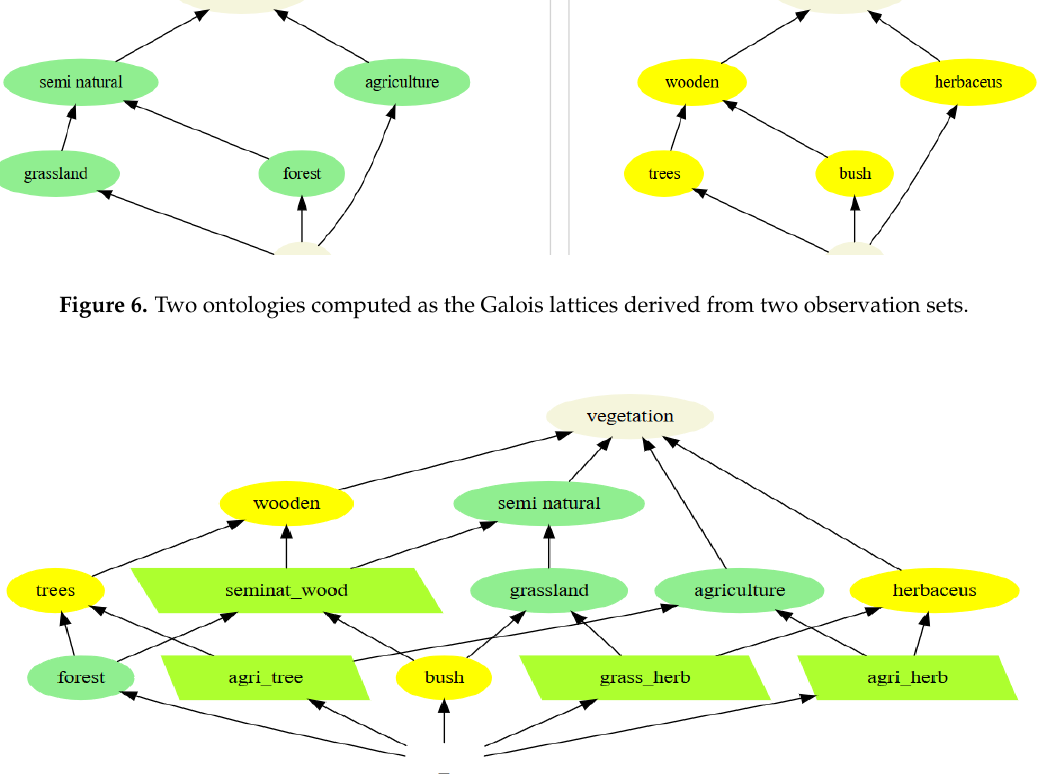
Figure 6. Ontology alignment: combining the two Galois lattices, and naming additional nodes.